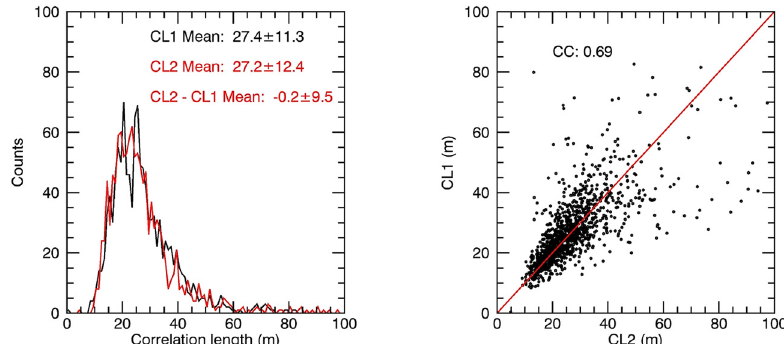
Figure 5. CL values calculated from method 1 (CL1) and method 2 (CL2) for 9 March 2017. The mean of CL1 is 27.4 ± 11.3 m. The mean of CL2 is 27.2 ± 12.4 m. The mean of CL2 − CL1 is − 0.2 ± 9.5 m. The correlation coefficient (CC) of CL1 and CL2 is 0.69.